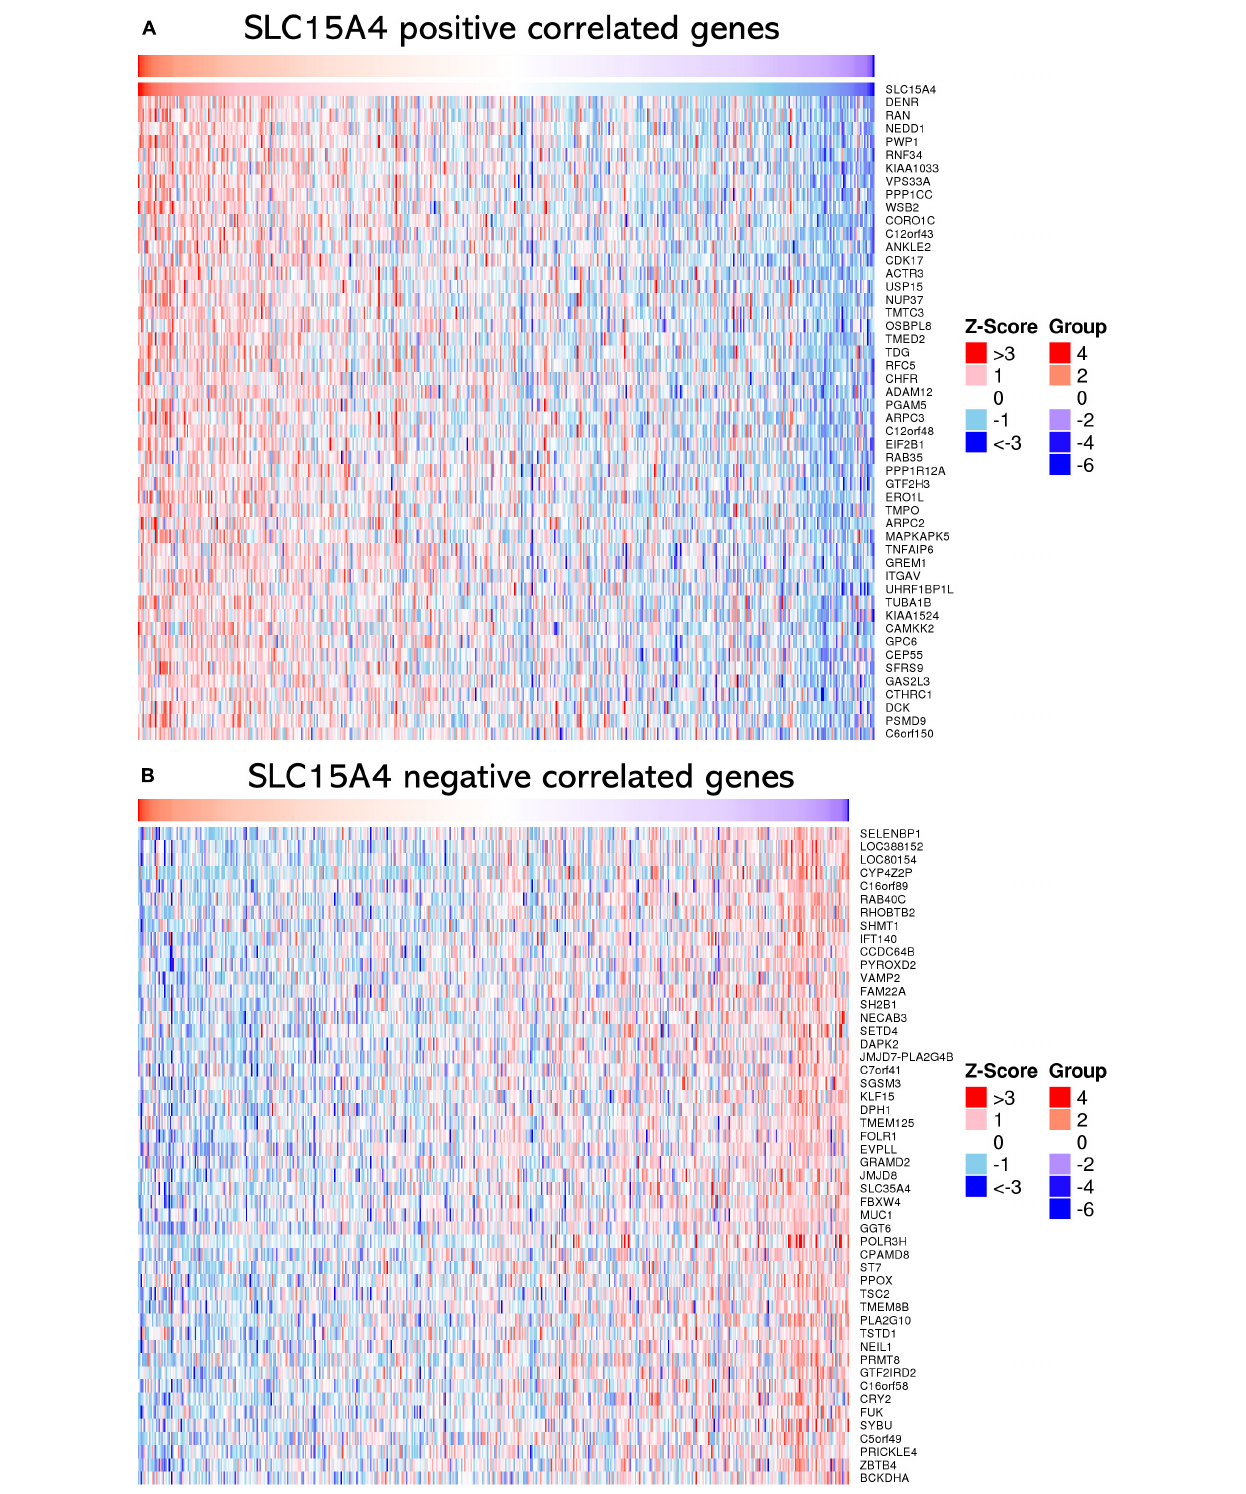
FIGURE 6 | Heatmap of correlated genes of SLC15A4 from TCGA-LUAD using RNA-seq data normalized by Z-score. Blue indicates negatively correlated expressed genes, and red indicates positively correlated expressed genes. (A) Heatmap of the top 50 positively correlated genes of SLC15A4 from TCGA-LUAD after normalization. (B) Heatmap of the top 50 negatively correlated genes of SLC15A4 from TCGA-LUAD after normalization. Red indicates cases with higher expression, and blue indicates cases with lower expression.